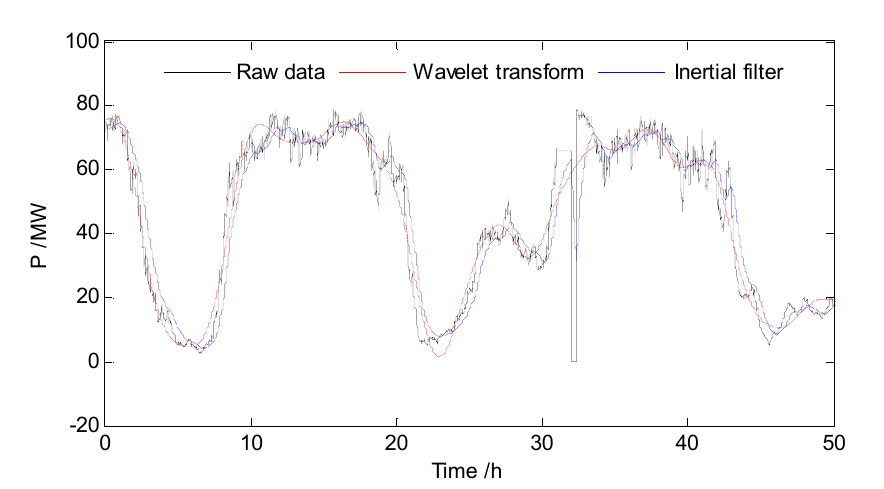
Figure 12. The comparison of power smoothing curve based on Inertia Filtering and Wavelet Transform in some wind farm about 50